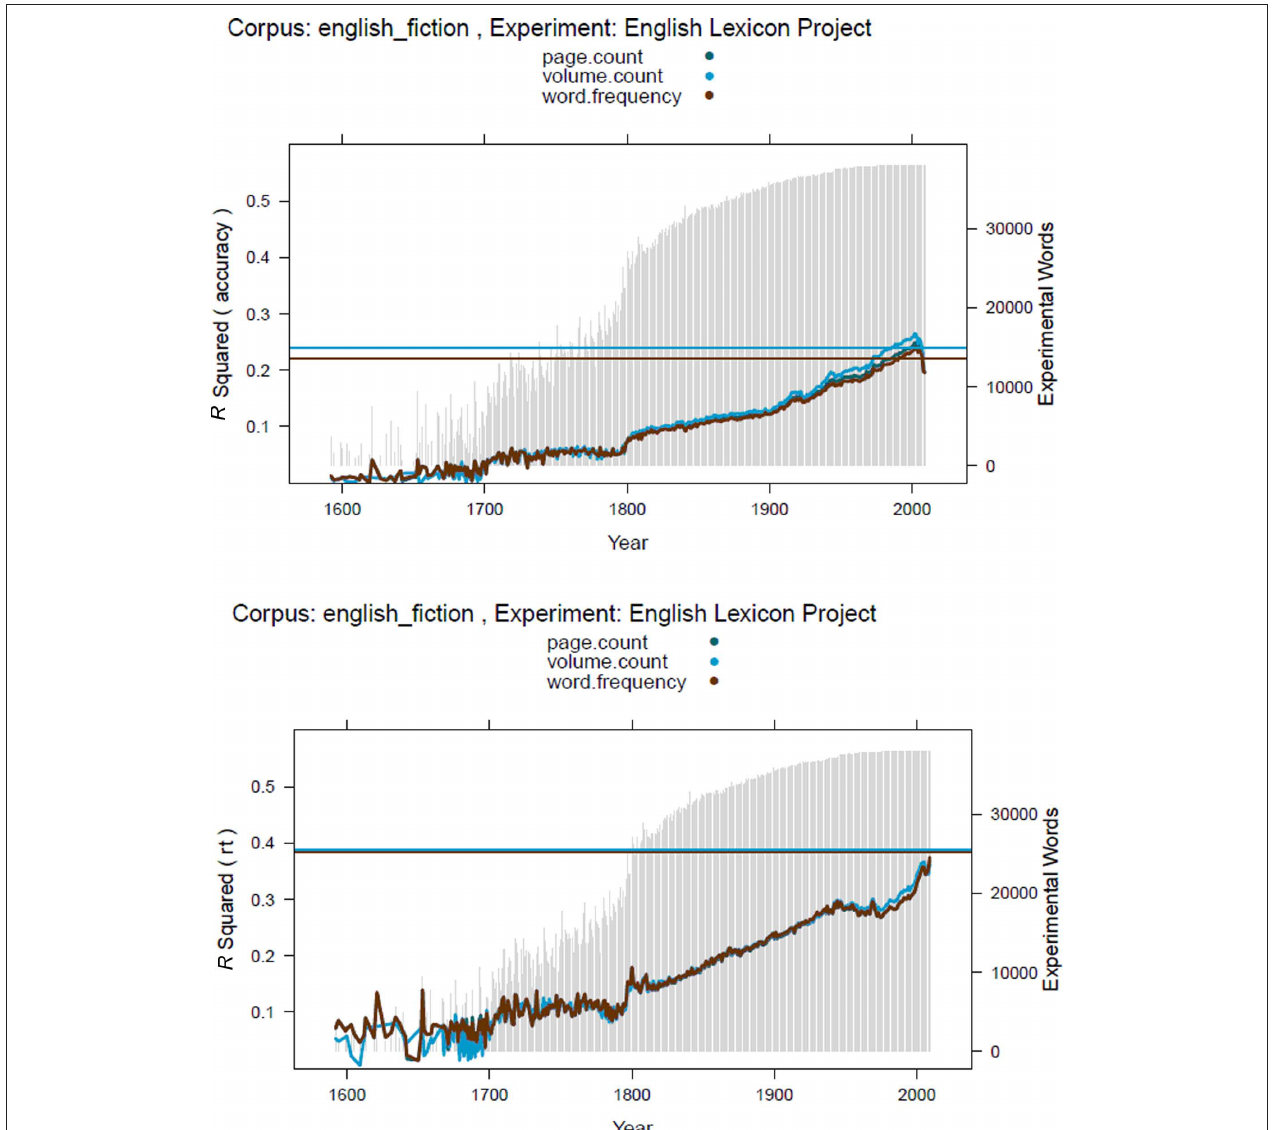
indicate the number of words from the Elexicon Project found in the Google books over the various years (ordinate to the right). The red horizontal line indicates the percentage of variance explained by SUBTLEX-US word frequency; the blue horizontal line indicates the percentage of variance explained by the number of SUBTLEX-US films in which the word appears. RT data based on words with accuracy >